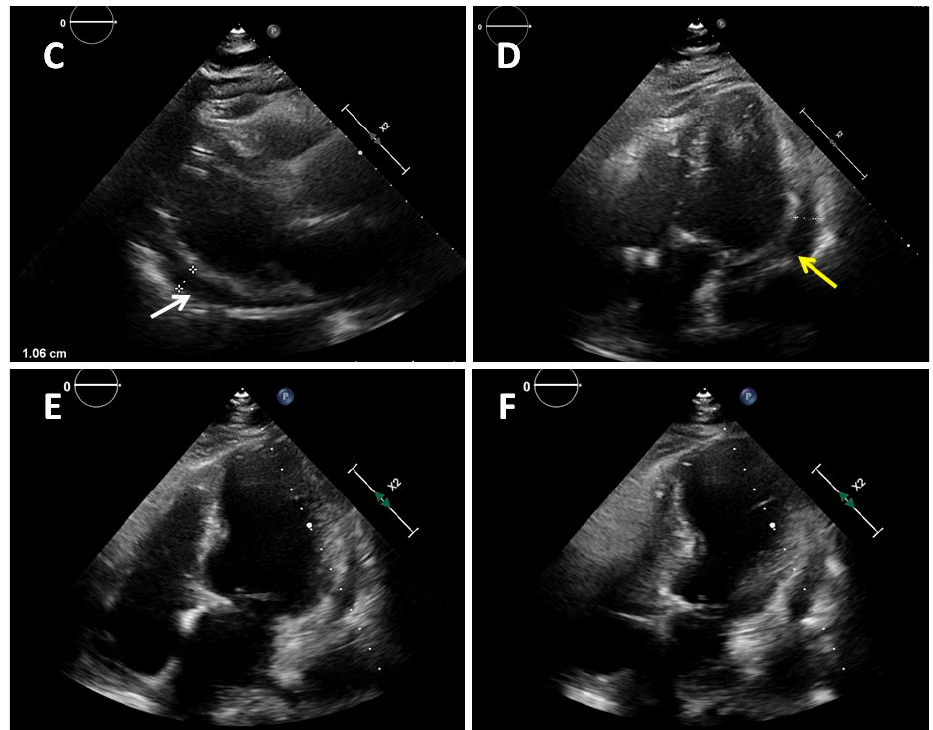
Figure 1. A 77-year-old obese woman with approximately 20 h of retrosternal pain was admitted to the clinic with suspected inferior STEMI infarction. The patient suffered from COVID-19 for four weeks before admission. On admission to the clinic, the patient reported chest pain. The ECG showed atrial fibrillation with a frequency of QRS about 100/min and ST-segment elevation in I, II, III, aVF, and V2-V6. The patient underwent coronary angiography, which revealed parochial atherosclerotic lesions in the coronary arteries ( A , B ) and, in the aortography, there were no signs of aortic dissection. The echocardiography showed normal valves function, good left ventricular systolic function with 58% ejection fraction (LVEF), and the presence of fluid in the pericardial sac, up to 10–11 mm behind the lower ( C , white arrow) and lateral ( D , yellow arrow) walls. The laboratory tests showed increased parameters of inflammation and normal levels of troponin and cardiac enzymes. Pericarditis was diagnosed and a treatment was started with colchicine, ibuprofen, enoxaparin, ceftriaxone, and levofloxacin. On the second day of hospitalization, the clinical condition of the patient deteriorated. There was an increase in renal parameters (creatinine—1.45 mg/dl, urea—100.5 mg/dl, and eGFR—37 mL/min) and atrial fibrillation with a fast QRS rate of 150/min. Pulmonary edema occurred, which was controlled by the intravenous infusion of furosemide and nitroglycerin. An echocardiogram was performed, which showed no significant changes. On the next day, the patient had a further deterioration in renal function with anuria. Hemodialysis was performed, followed by a return to diuresis. In the following days of hospitalization, the clinical condition of the patient improved. An echocardiographic examination was repeated in the patient every 1–2 days, confirming the good systolic function of the left ventricle and a constant amount of fluid in the pericardial sac. On the sixth day of hospitalization, the patient experienced a sudden cardiac arrest in the ventricular fibrillation (VF) mechanism. Resuscitation activities were undertaken, obtaining an atrial rhythm of about 90–100/min. In addition, the electrocardiogram showed a right bundle branch block and left bundle branch posterior bundle block (RBBB + LPH), QTc—510 ms. The patient was connected to a respirator and administered dobutamine, noradrenaline by continuous intravenous infusion, and amiodarone. The echocardiography revealed extensive abnormalities of contractility with akinesis of the apex, apical, and middle segments of all left ventricular walls, which may be consistent with Takotsubo syndrome ( E , F ). The ejection fraction was estimated at approximately 15%. There was a small amount of fluid in the pericardial sac. After a few hours, the patient returned to sudden cardiac arrest by VF and pulseless electrical activity (PEA). The resuscitation measures undertaken turned out to be ineffective, and the patient was pronounced dead. Patients with cardiovascular diseases are at risk of a severe course of COVID-19,